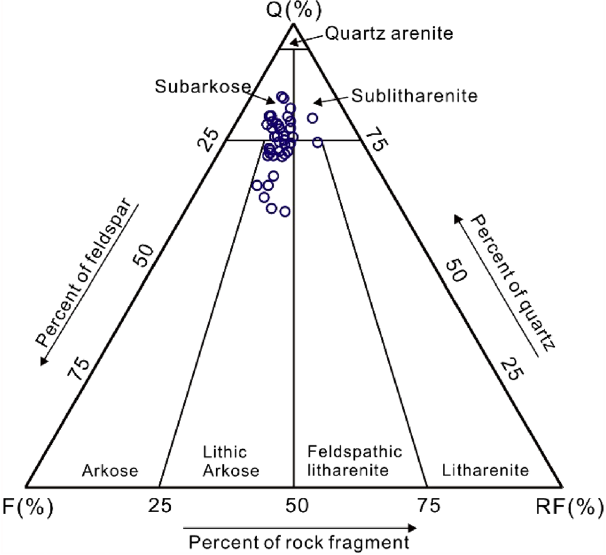
Figure 3. Ternary diagram exhibiting the framework grain composition of the Miocene Zhujiang Formation in Z21 oil–gas field in Huizhou depression. Q = quartz, F = feldspar, RF = rock fragments. This figure shows that the studied interval is dominated by subarkose and lithic arkose.